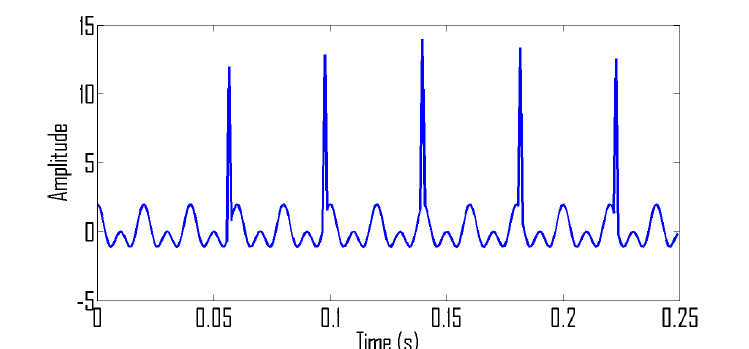
Figure 4. A synthetic PQ signal composed of two tones and spikes.